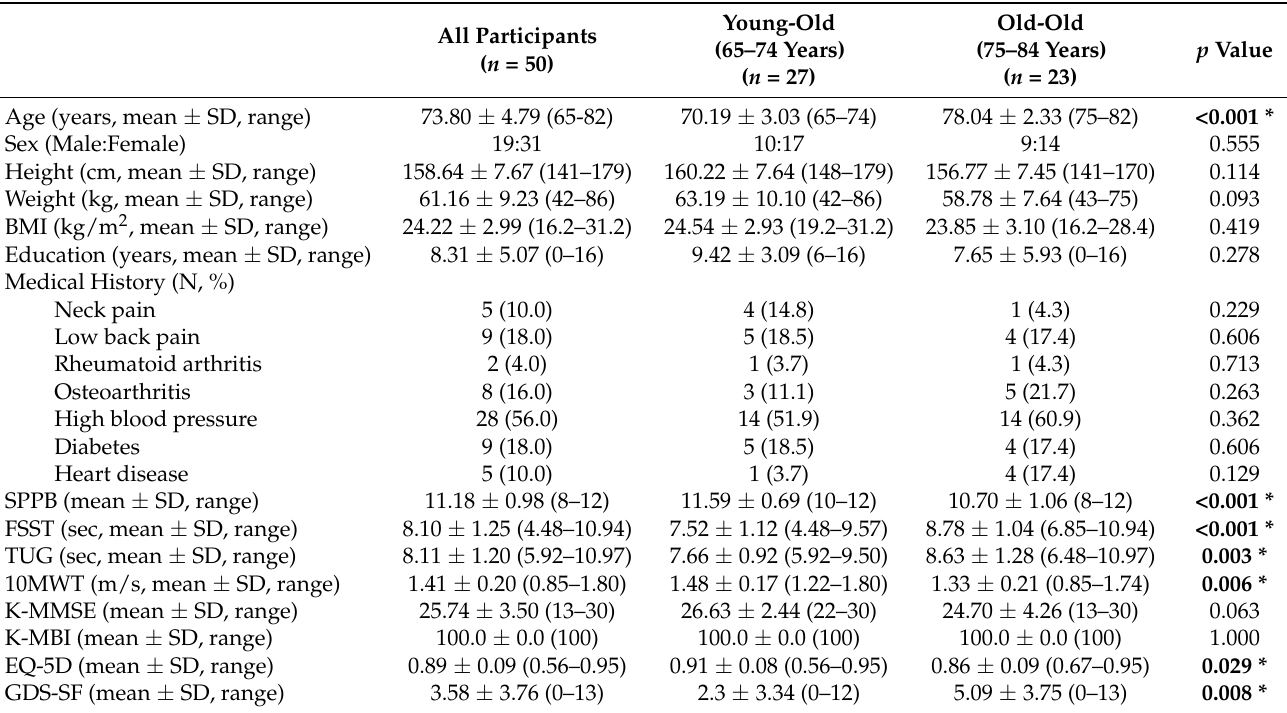
Table 1. Demographic characteristics and functional differences between the young-old and the old-old elderly. All